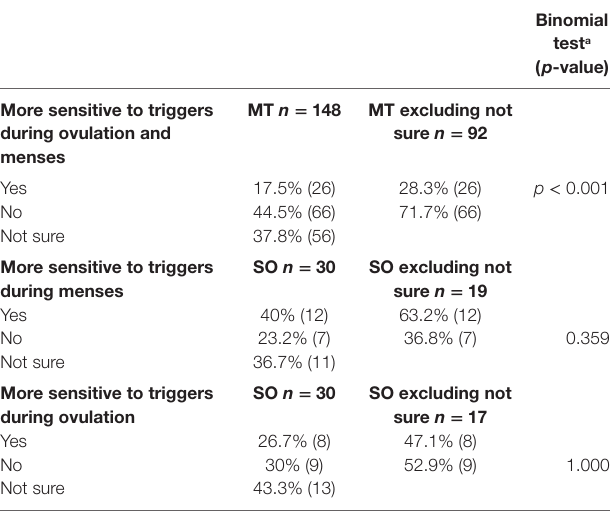
Table 6 | Reported sensitivity to triggers during different phases of the menstrual cycle, presented as a percentage of the group and raw number.